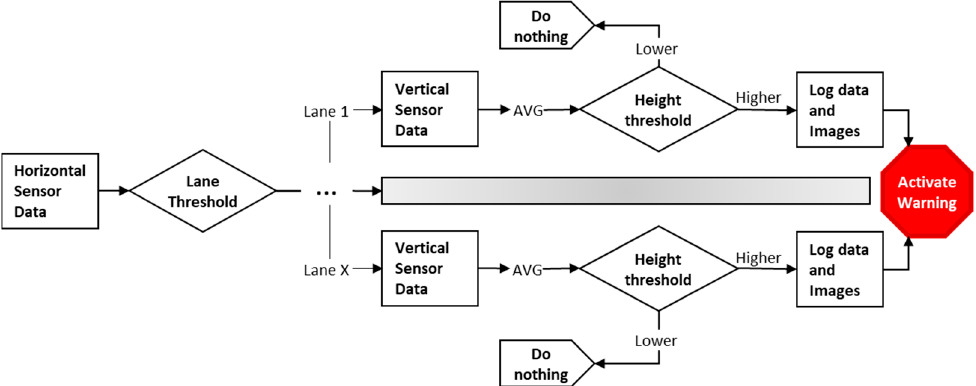
Figure 4. Overheight detection and warning algorithm for x lanes. Individual sensor setups can be installed per lane, with horizontal measurements determining both the presence of a vehicle and the specific lane in which it is detected.